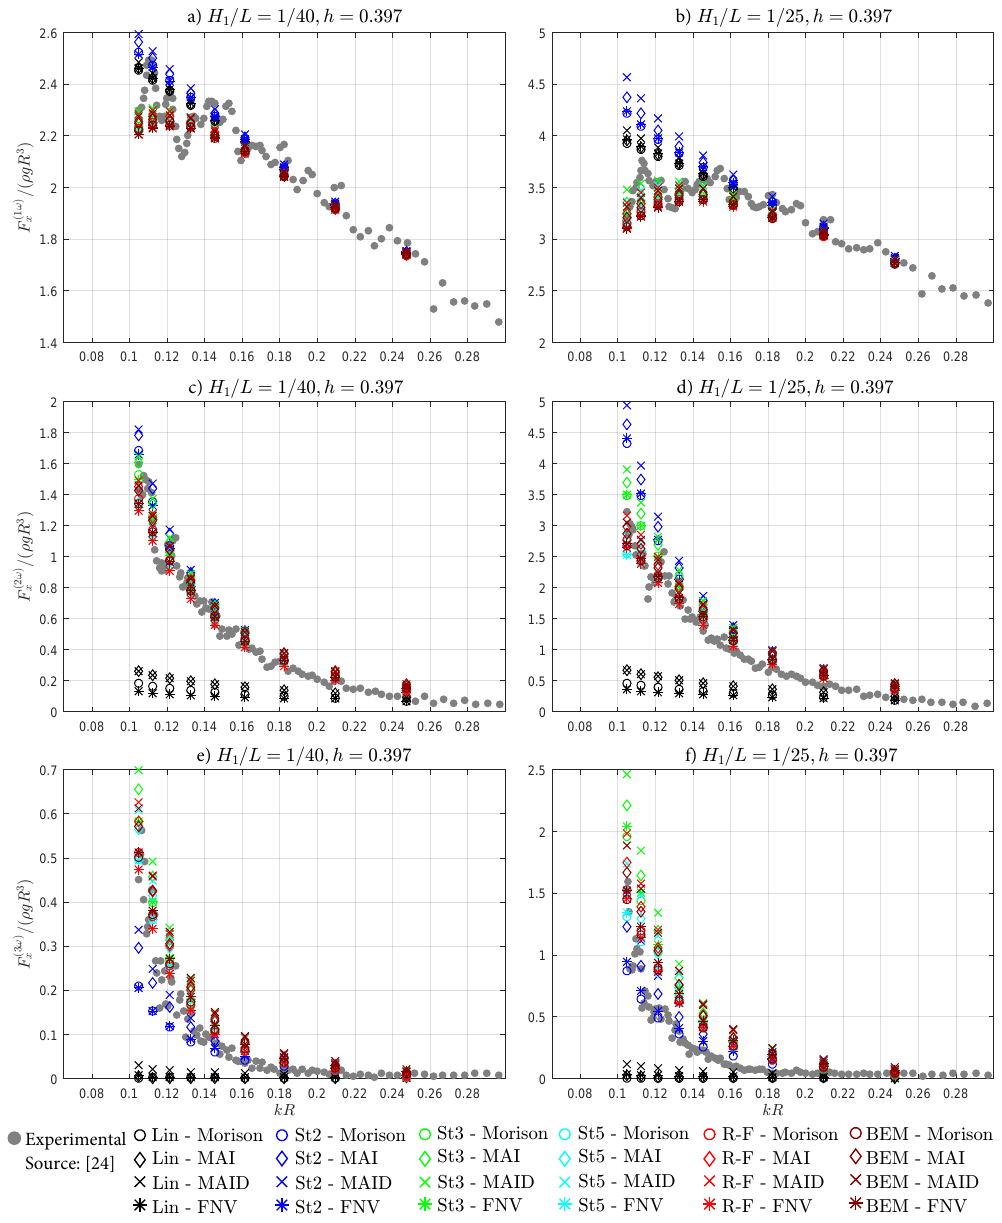
Figure 10. First ( a – b ), second ( c – d ) and third ( e – f ) harmonics of the normalized horizontal force over the increasing wave number kR for two steepnesses of H 1 / λ = 1/40 ( a , c , e ) and H 1 / λ = 1/25 ( b , d , f ) for the depth h = 0.397 m , compared with experiments from [24] (grey